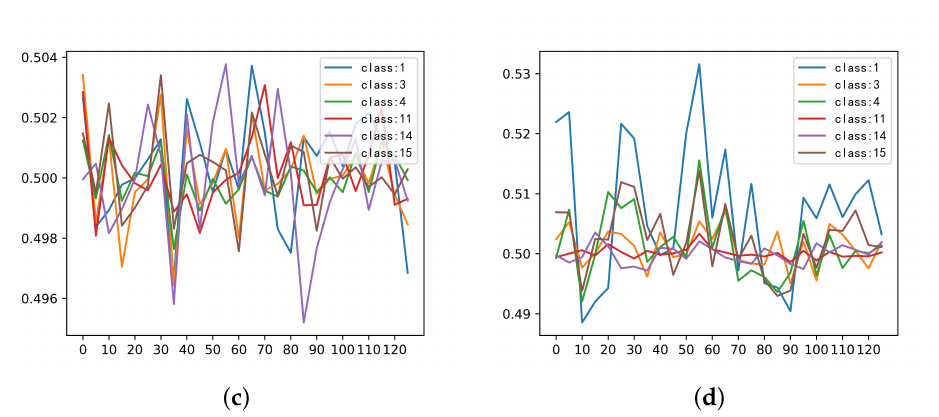
Figure 12. Averaged spectral dimension stimulus value for the six classes in different SpectralSE blocks: ( a ) SpectralSE 1; ( b ) SpectralSE 2; ( c ) SpectralSE 3; and ( d ) SpectralSE 4.